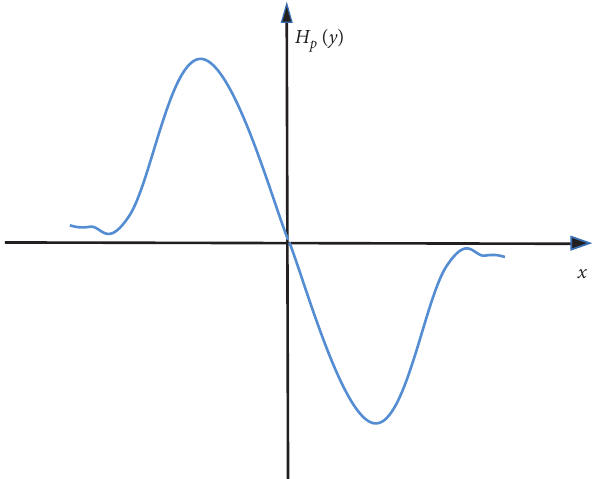
( Y ) peak of magnetic p